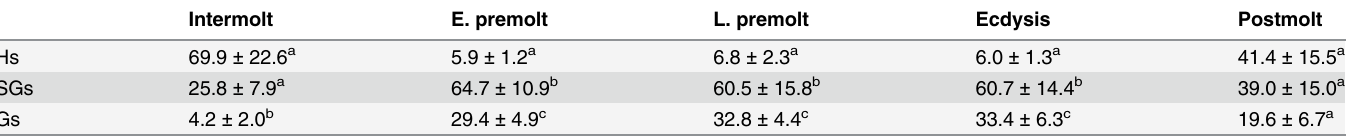
Table 3. Changes in different cell types in hemocyte populations of the hemolymph of C . sapidus during the molt